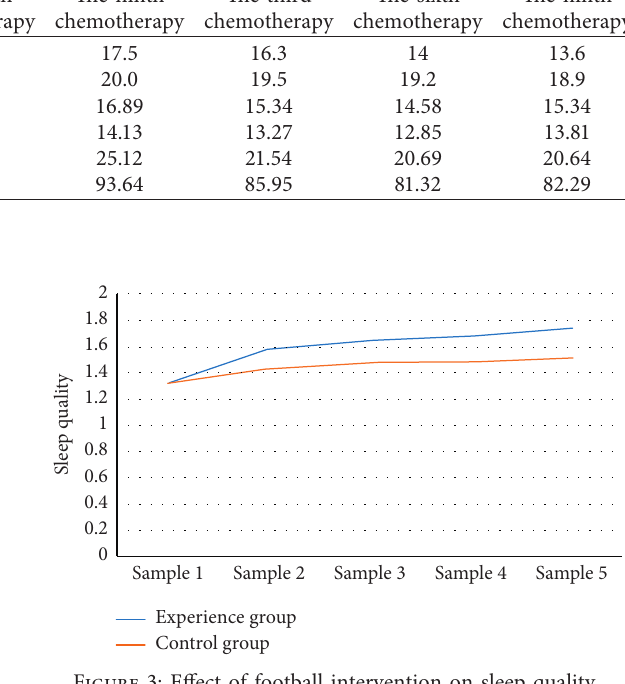
Figure 2: Comparison of quality of life scores between the two groups after the intervention.